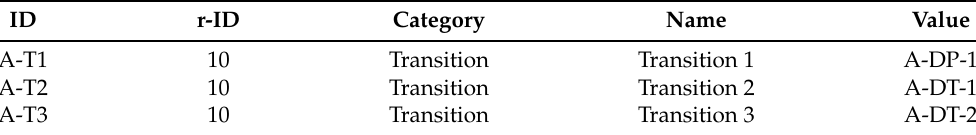
Table A2. Annotated Transitions for the bike crank use case.